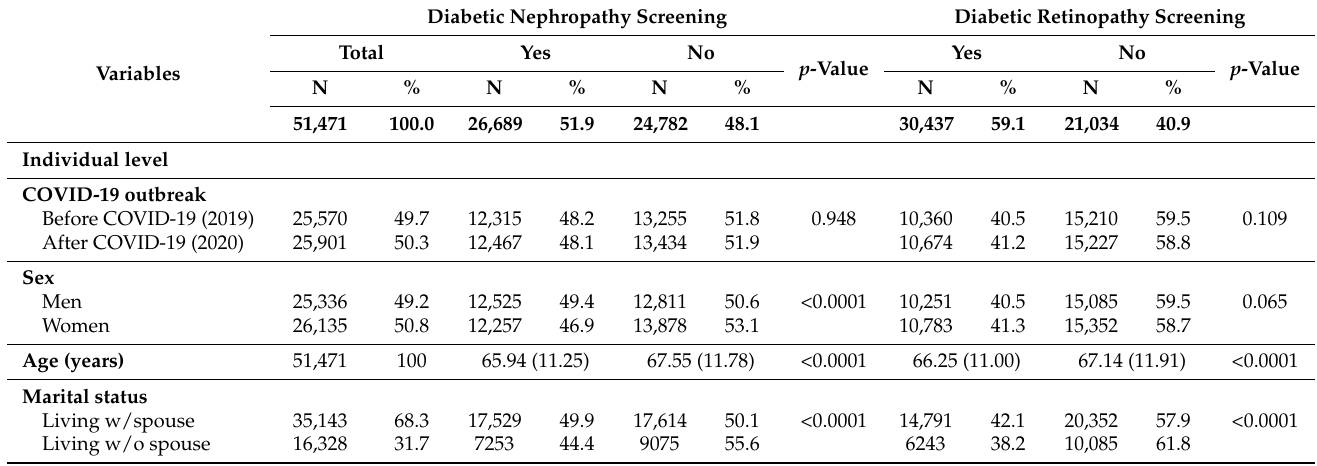
Table 2. General characteristics of the study